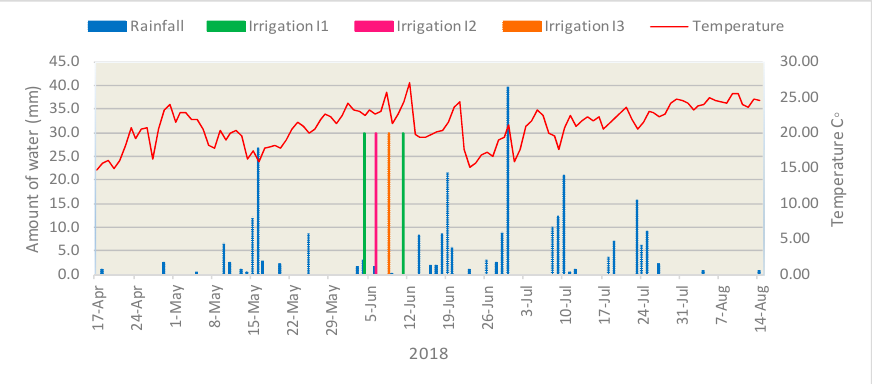
Figure 2. Irrigation water applied, mean daily air temperature (°C), and daily precipitation (mm) in 2018.